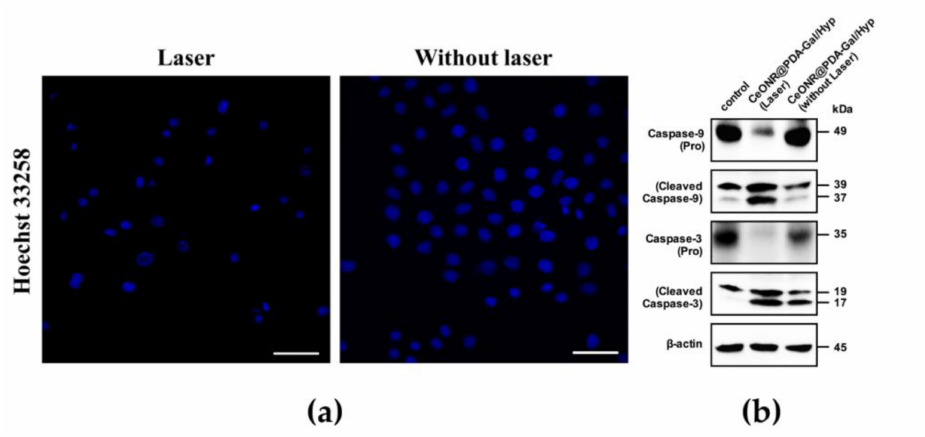
Figure 7. ( a ) CLSM images of the nuclei of HepG2 cells cultured with CeONR@PDA-Gal / Hyp (Hyp 0.25 µ M) with or without laser irradiation. Scale bar: 50 µ m. ( b ) Western blot assay for Caspase-3